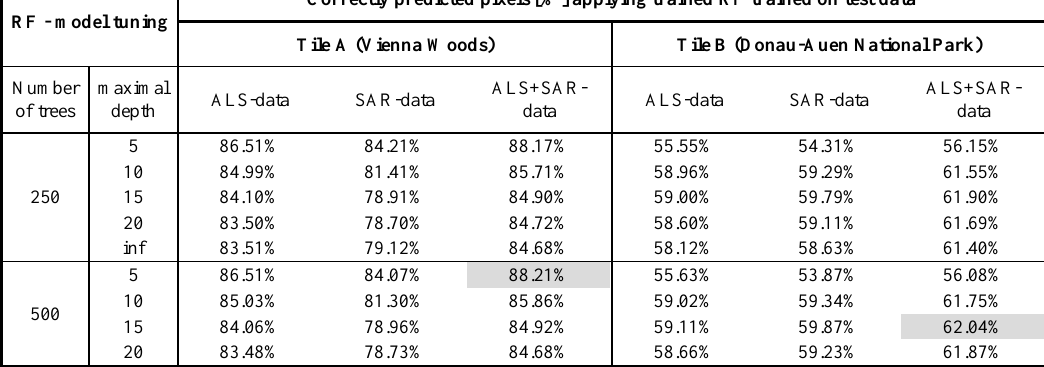
Table 4. Tuning of the RF and prediction accuracy when applying the trained models on the test data. The best prediction results are highlighted and used for detailed analysis in Table 5.